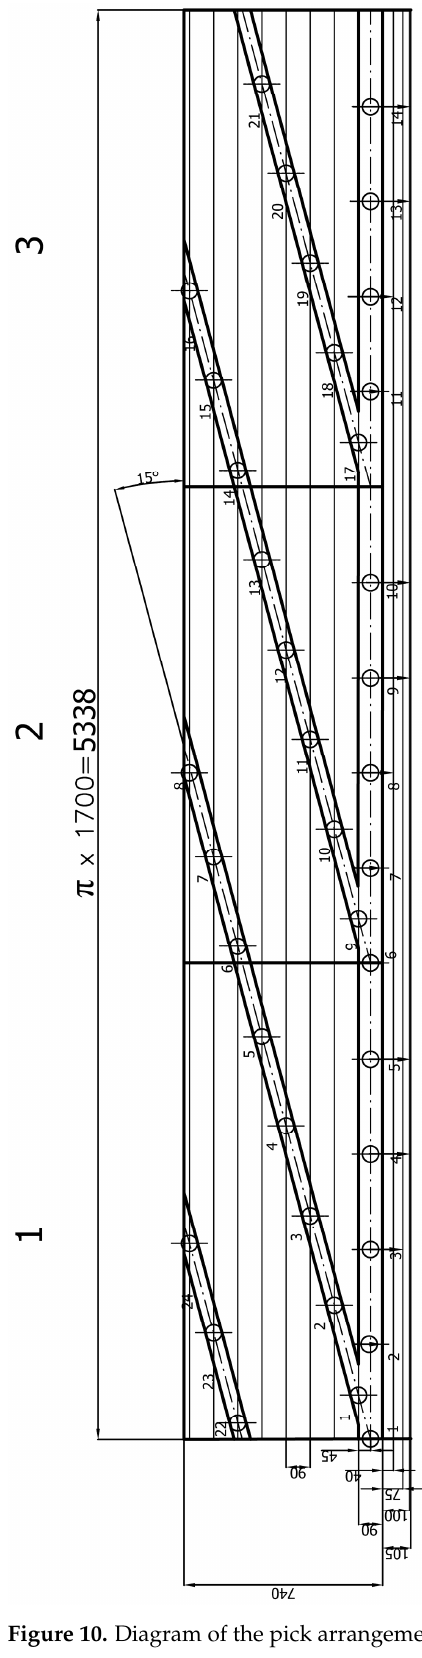
Figure 10. Diagram of the pick arrangement of the ∅ 2030 × 800 cutting head with 38